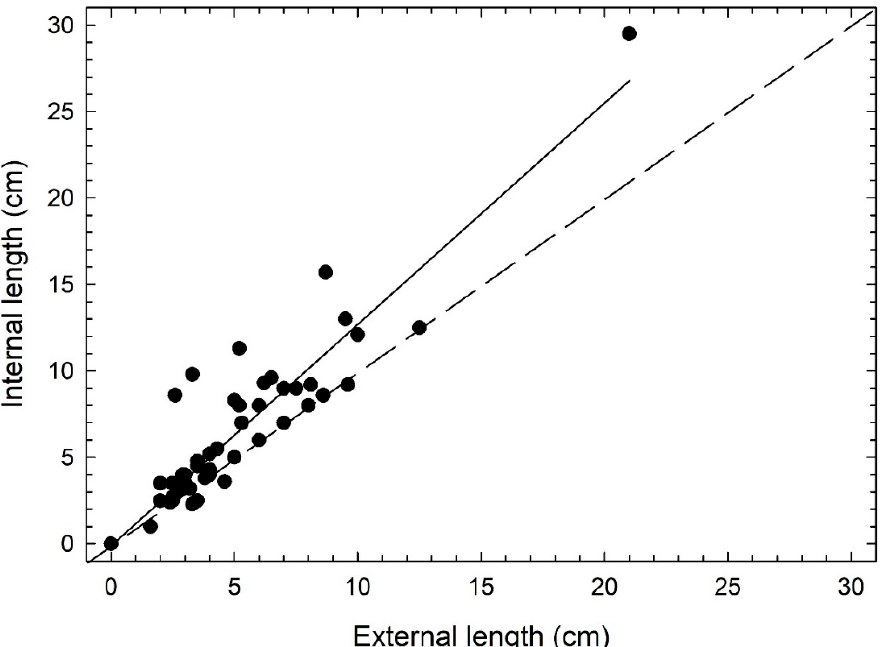
Figure 3. Linear regression analysis of the internal assessment of bark inclusion length vs. the external (nondestructive) assessment of bark inclusion length in canes of Farthing southern highbush blueberry ( n = 20, study 2). The two measures were strongly correlated ( r = 0.916, p < 0.0001), and the slope of the regression line was 1.281 ± 0.077 (SE). The dashed line corresponds to a 1:1 relationship.